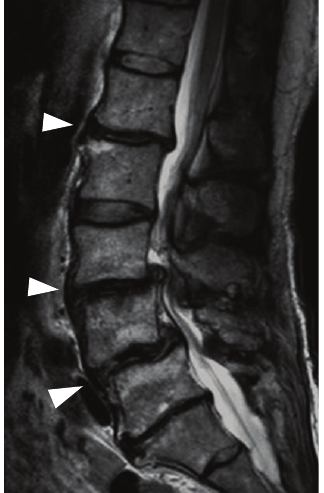
Figure2:SagittalT2-weightedmagneticresonanceimagebeforethe spinal fusion operation showing severe disc degeneration (arrow- head) at the L1/2, L3/4, and L4/5